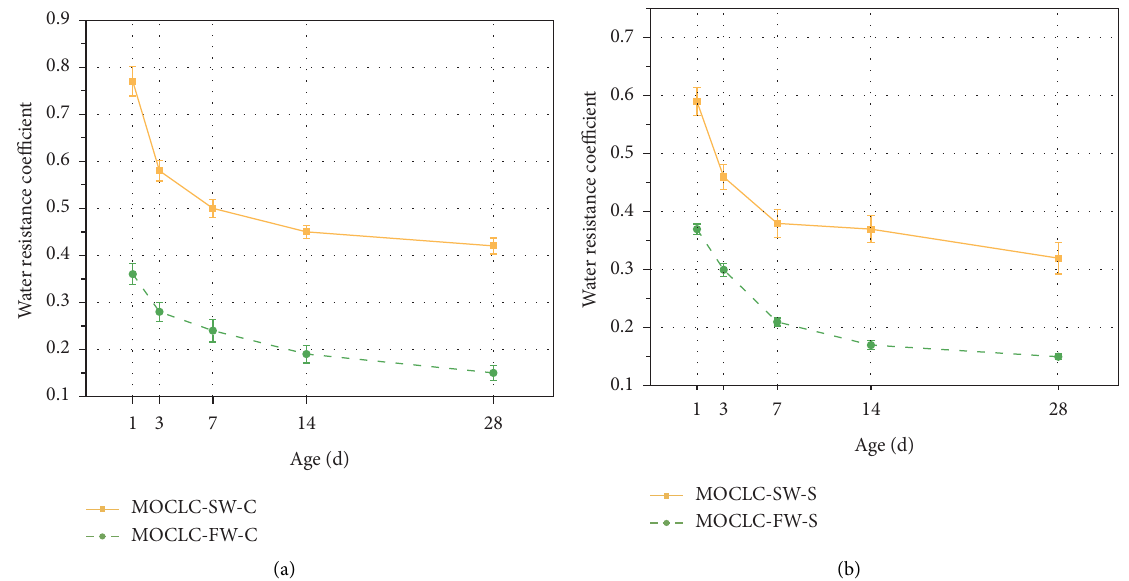
Figure 7: Water resistance coefcient of MOCLC under diferent water immersion conditions.